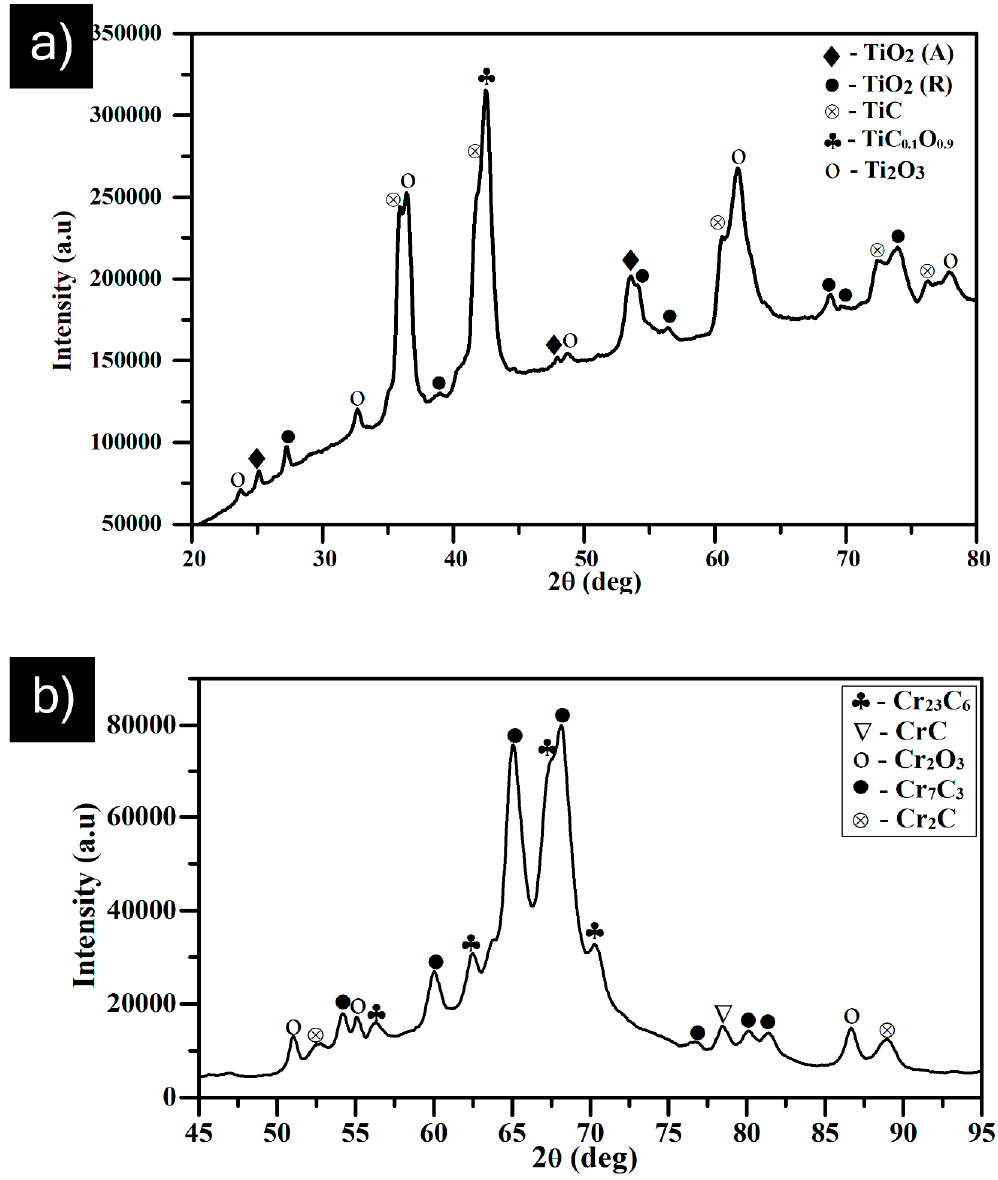
Figure 7. XRD analysis of the as-sprayed surface of ( a ) TiC coating; ( b ) chromium carbide coating.